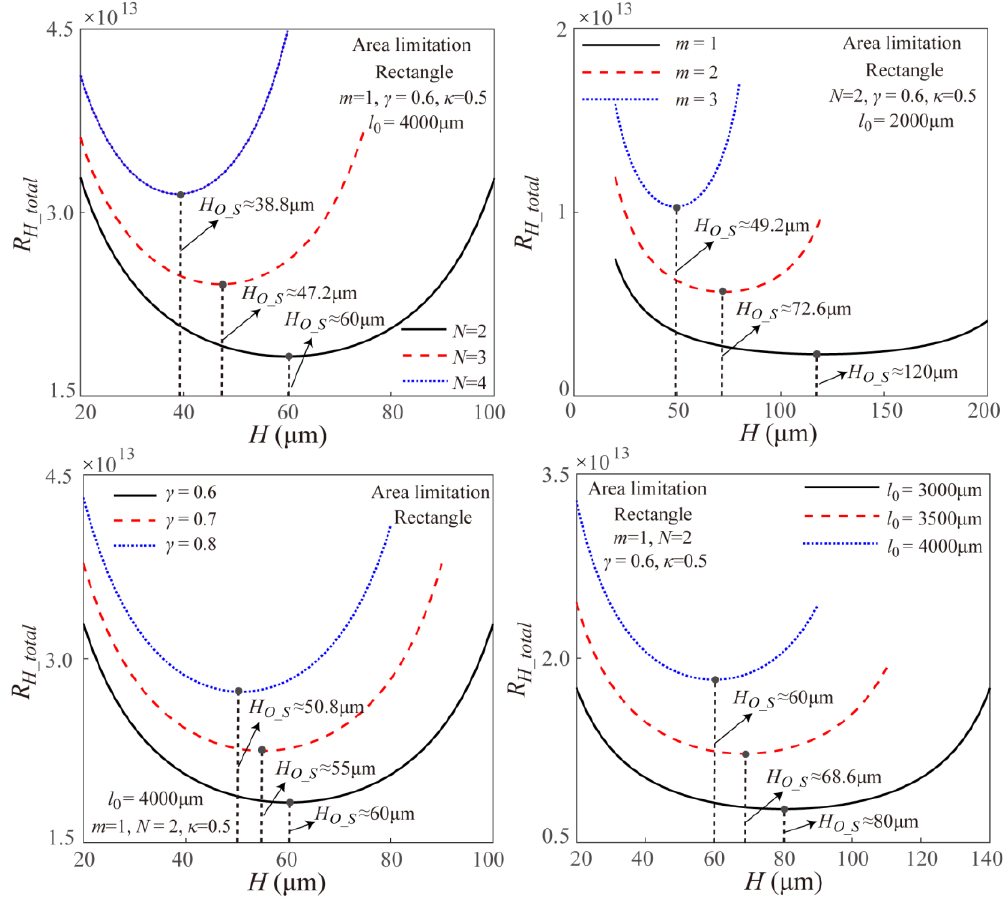
Figure 9. Effects of channel height on the total EOF fluidic resistance in the symmetric fractal rectangular microchannel network with different N , m , γ, and l 0 under surface area limitation.